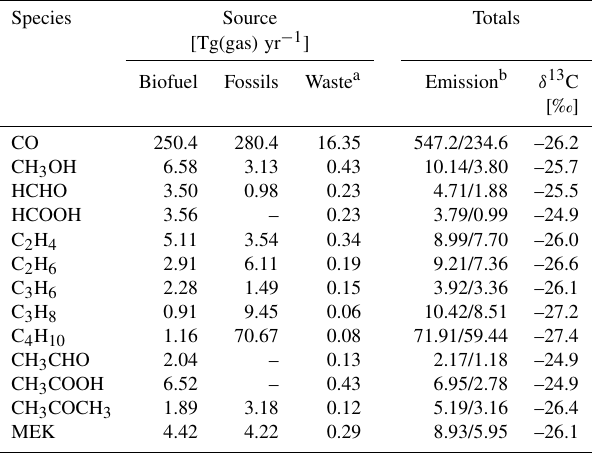
Table 2. Anthropogenic emission sources strengths and their iso- topic